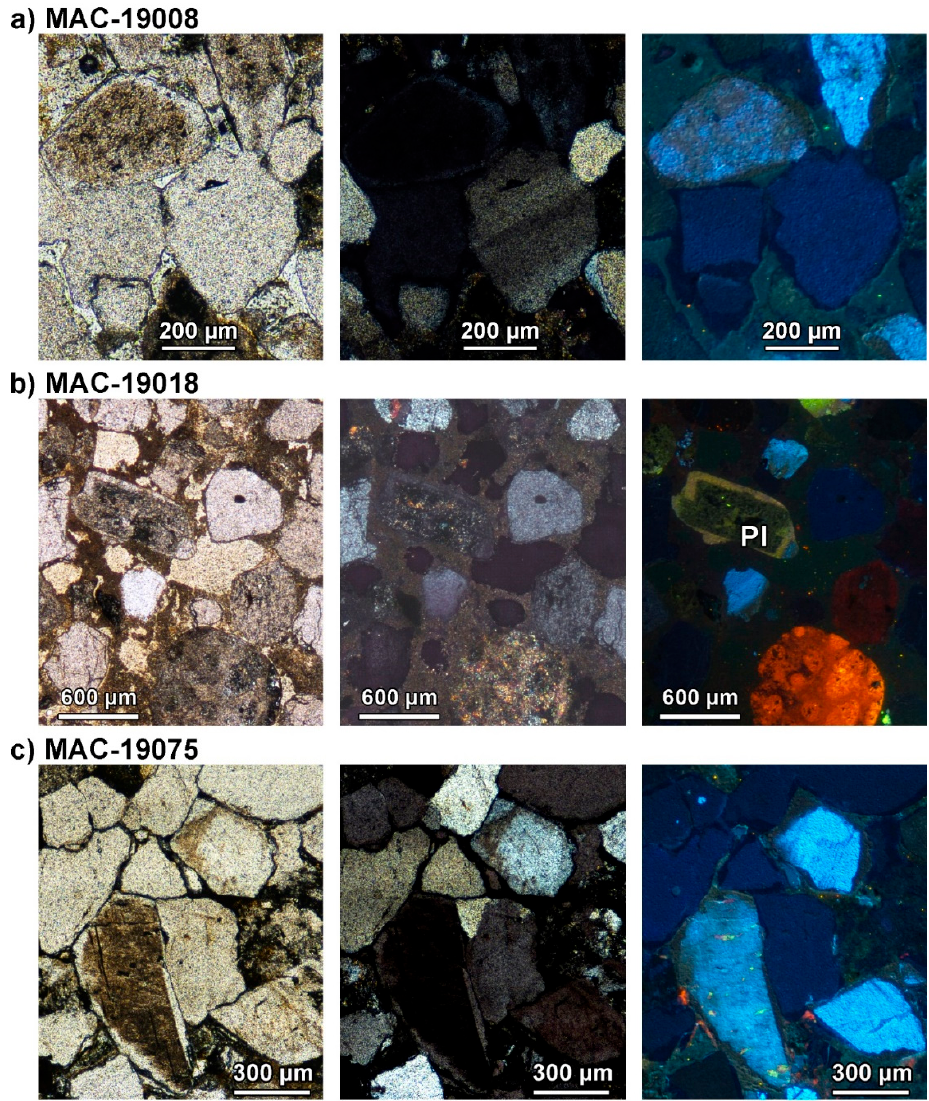
Figure 9. Petrographic images of the sampled sculptures from Barcino including PPL (left), XPL (middle), and CL (right) micrographs of the same areas. ( a ) sample of MAC-19008 togatus, exhibiting typical features of Montjuïc sandstone (K-feldspar and quartz clasts with authigenic overgrowths). ( b ) sample of MAC-19018 feminine sculpture, exhibiting micrite-size cement, plagioclase (Pl) and a carbonatic intraclast made of pellets (orange in CL mode). ( c ) Sample of MAC-19008 togatus, exhibiting typical features of Montjuïc sandstone.